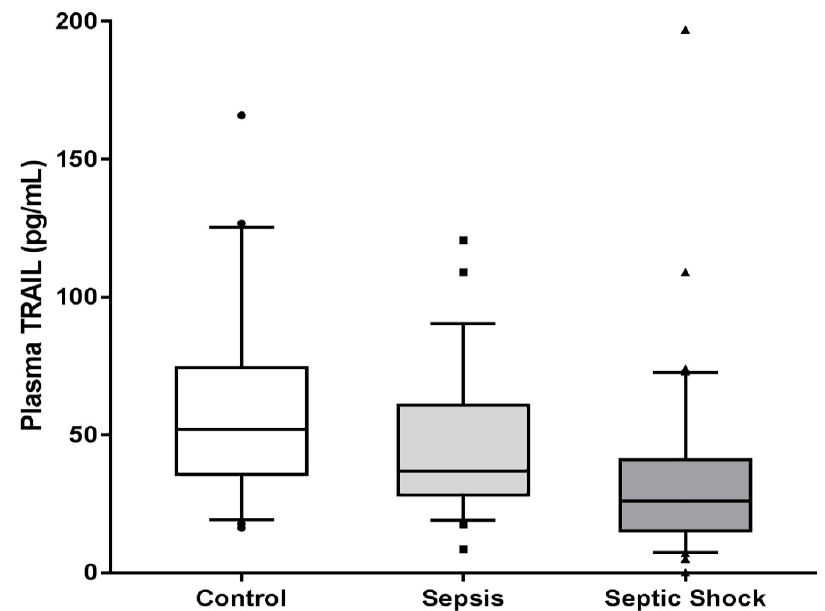
Figure 2. Plasma levels of Tumor necrosis factor TNF-related apoptosis-inducing ligand (TRAIL) in control, sepsis, and septic shock ( p for trend < 0.001).